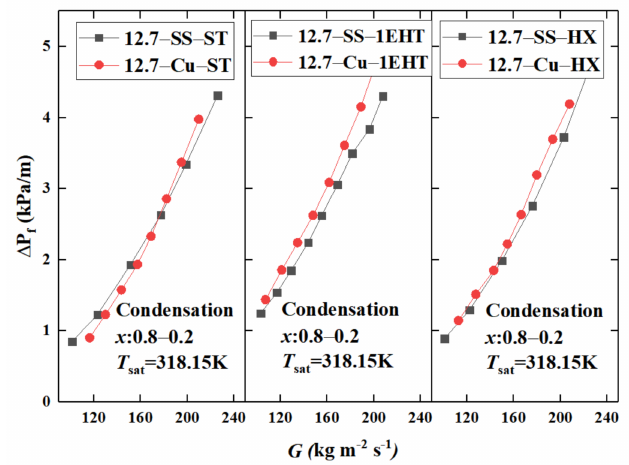
Figure 8. Variation of condensation pressure drop ( ∆ P ) inside smooth and enhanced, 12.7-mm-OD tubes with mass flow rate ( G